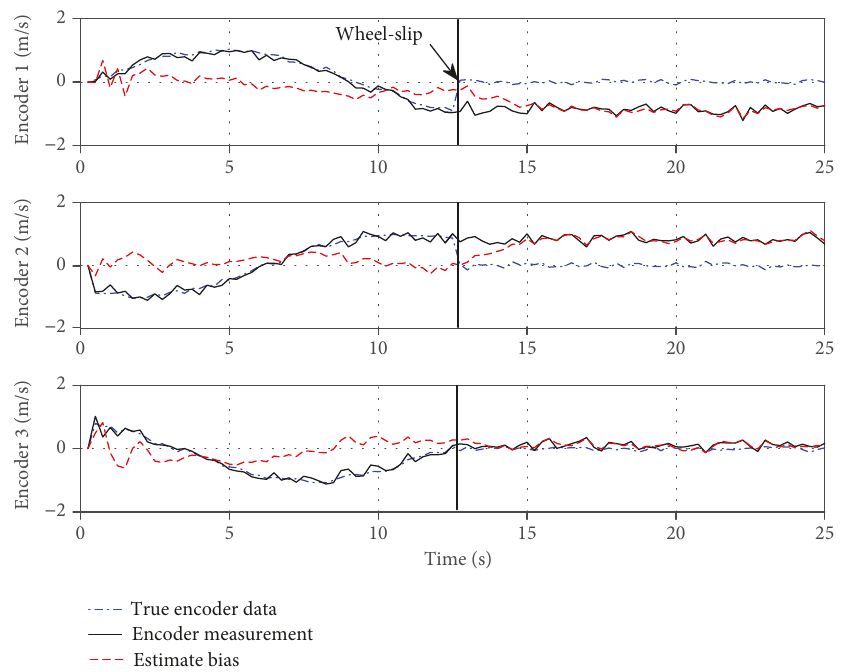
Figure 8: Encoder measurement bias estimate